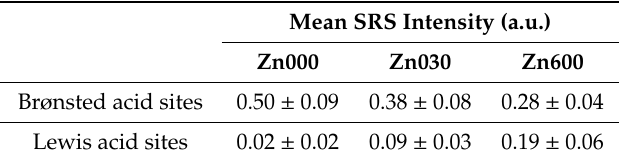
Figure 4. Evolution of the mean SRS intensity of pyridinium cation (red) and complexed pyridine (blue) for single ZSM-5 crystals as a function of the Zn exchange time. The mean SRS intensity of Lewis acidity is o ff set by 5 min for clarity. Table 2. Mean SRS intensity of the ν 1 mode of pyridine chemisorbed on Brønsted and Lewis acid sites.